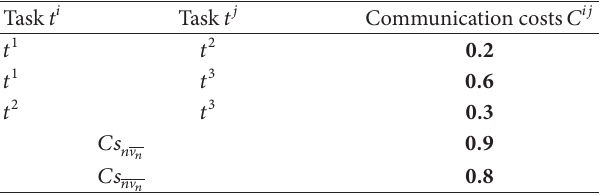
Table 11: Moderate slowdown. Solver